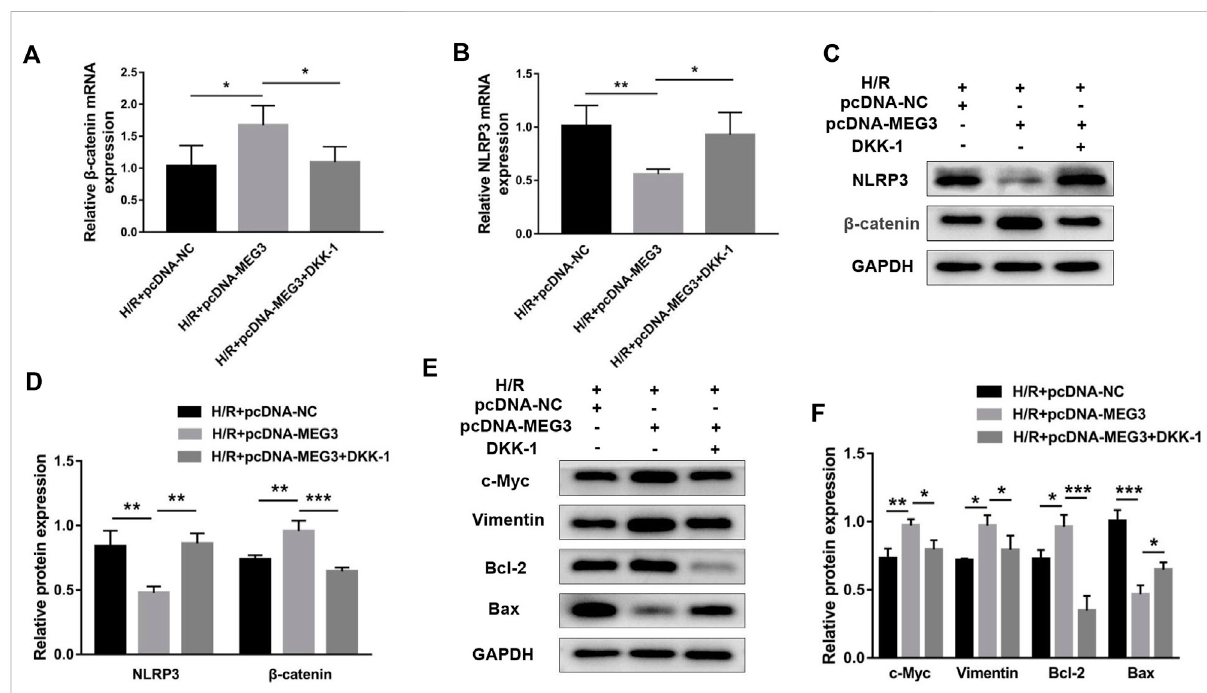
FIGURE 6 BlockingWnt/ β -CateninsignalingreversedtheeffectofMEG3ontheexpressionlevelsof β -CateninandNLRP3.qRT ‒ PCRanalysisof β -Catenin (A) andNLRP3 (B) inHTR8/SVneocellsoverexpressing MEG3 treatedwithDKK-1( n =4/group). (C,D) Westernblotanalysisof β -CateninandNLRP3in HTR8/SVneo cells overexpressing MEG3 treated with DKK-1 ( n = 3/group). (E,F) Western blot analysis of the expression levels of c-Myc, Vimentin, Bcl-2, and Bax ( n = 3/group). GAPDH was used as an endogenous control. * p < 0.05; ** p < 0.01; *** p <